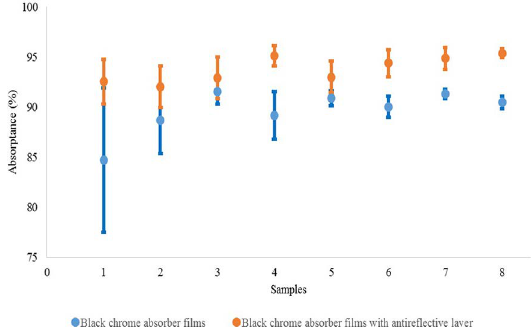
Figure 3. Comparison between the average absorption obtained by the films without and with the AR